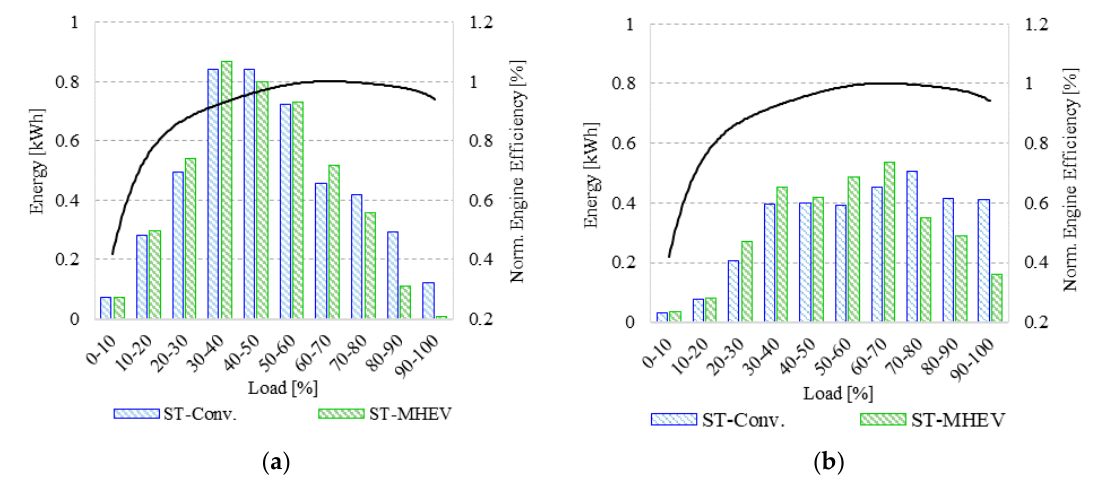
Figure 12. Energy delivered by the engine grouped in load bins; normalized engine efficiency at 2000 RPM on the right axis: ( a ) WLTC; ( b ) RTS-95.